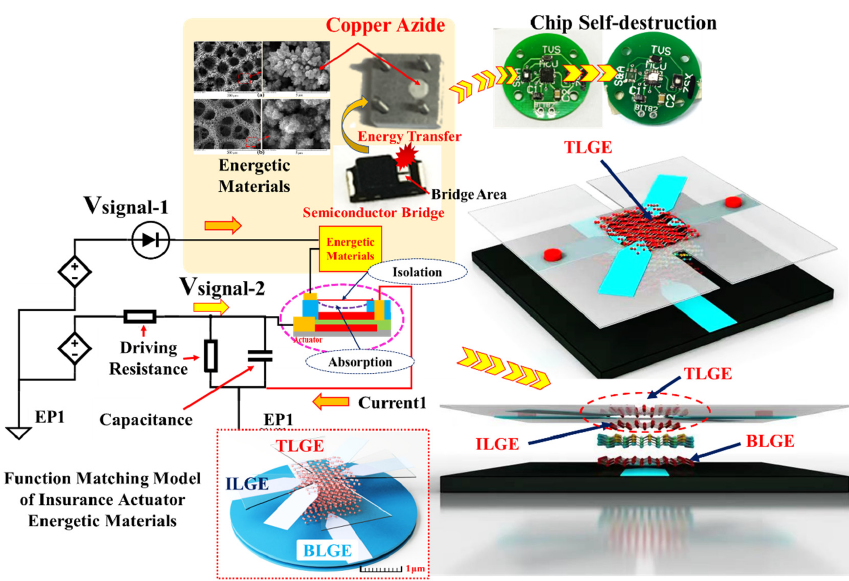
Figure 2. ISC self-destruction mechanism based on energetic materials and insurance actuator.